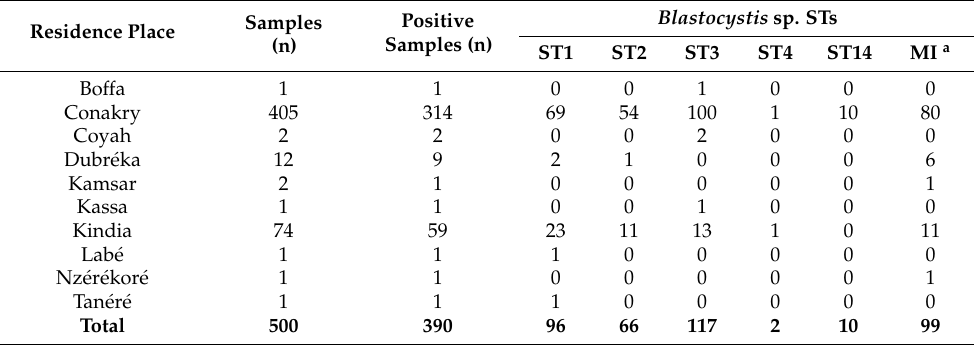
Table 3. Prevalence and ST distribution of Blastocystis sp. according to the residence place of participants. Blastocystis sp. STs Positive Residence Place Samples Samples (n) (n) ST1 ST2 ST3 ST4 Boffa 405